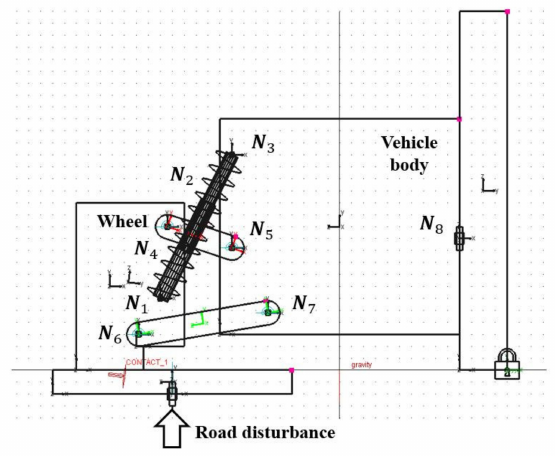
Figure 8. Quarter-vehicle model in